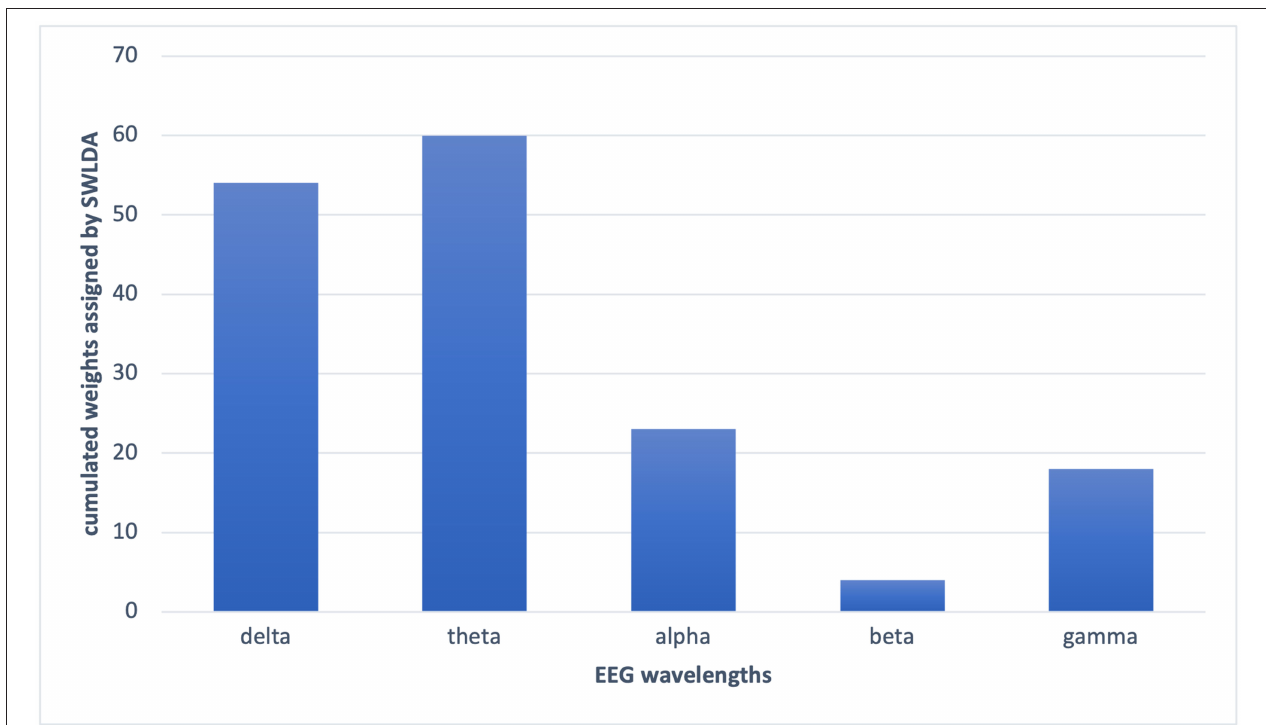
FIGURE 6 | The cumulated weights assigned by SWLDA to each wavelength features. SWLDA mostly selected theta band features as informative and assigned the largest weights to the theta band features.